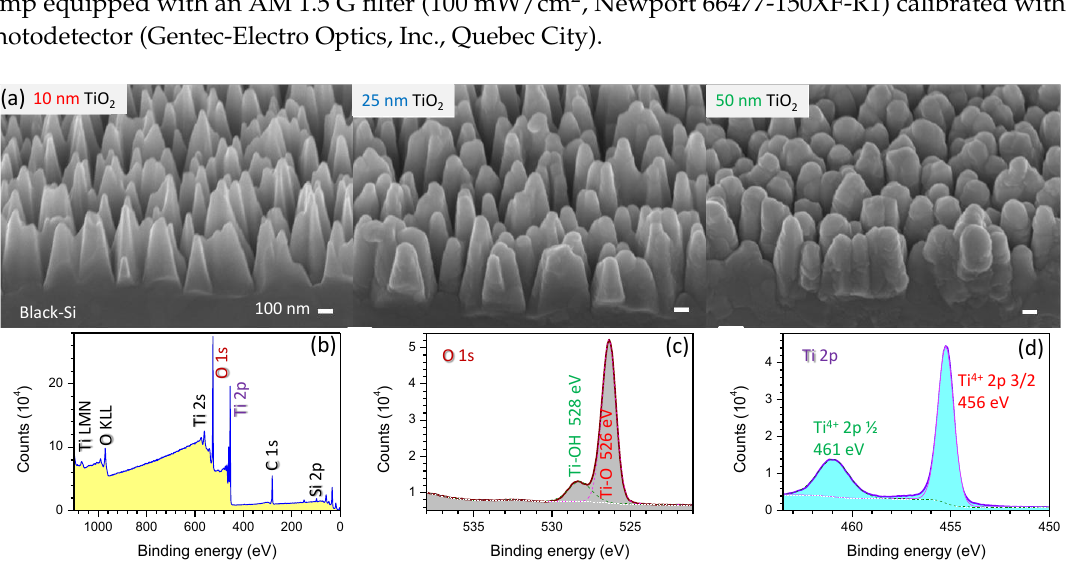
Figure 2. Surface characterization of b-Si photoelectrodes. ( a ) Side-view SEM images of b-Si coated with different thickness of TiO 2 by atomic layer deposition (ALD). Scale bars 100 nm. b-Si was etched for 40 min. ( b – d ) XPS surface analysis for wide and narrow spectral windows at O1s and Ti2p bands from b-Si sample coated with 25 nm of TiO 2